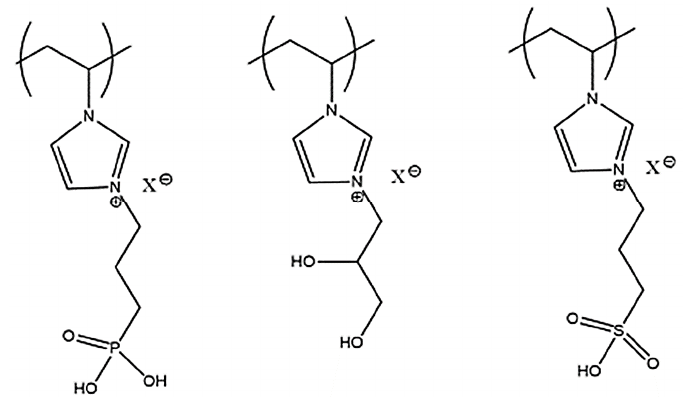
Figure 1. Chemical structures recently reported for cationic poly (ionic liquids) (PILs) [28].